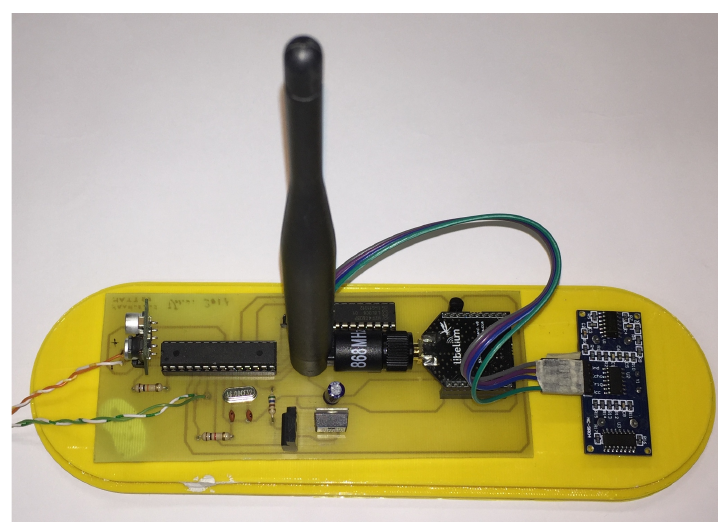
Figure 2. Circuit of the IoT sensor